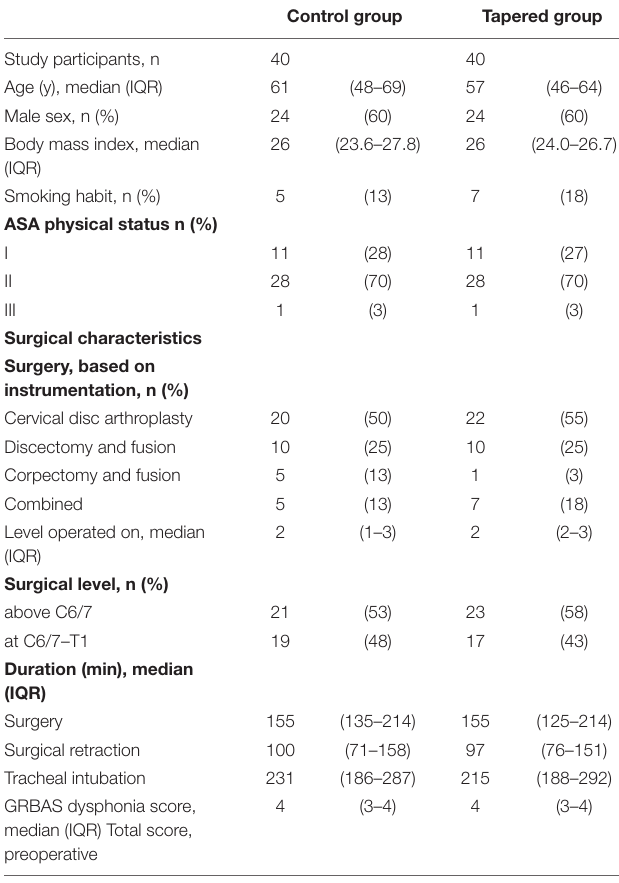
TABLE 1 | Patients’ characteristics and surgical data.